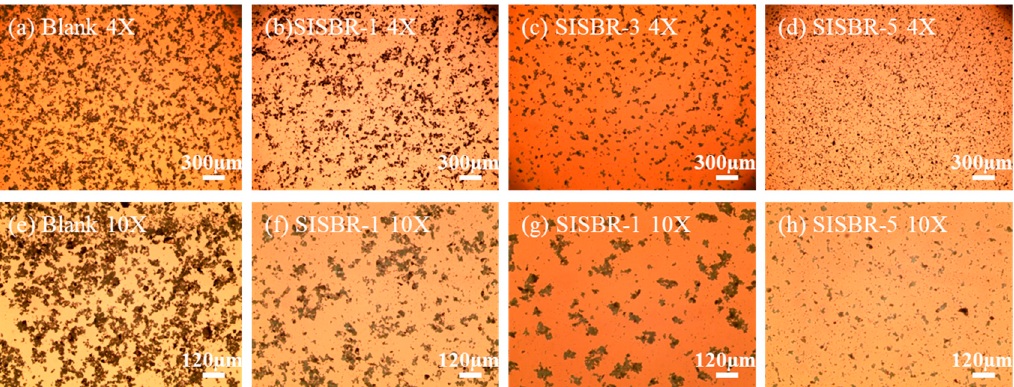
Figure 7. Microstructure of cement paste; pure cement in 4X ( a ) and 10X ( e ), SISBR-1 sample in 4X ( b ) and 10X ( f ), SISBR-3 sample in 4X ( c ) and 10X ( g ), SISBR-5 sample in 4X ( d ) and 10X ( h ).